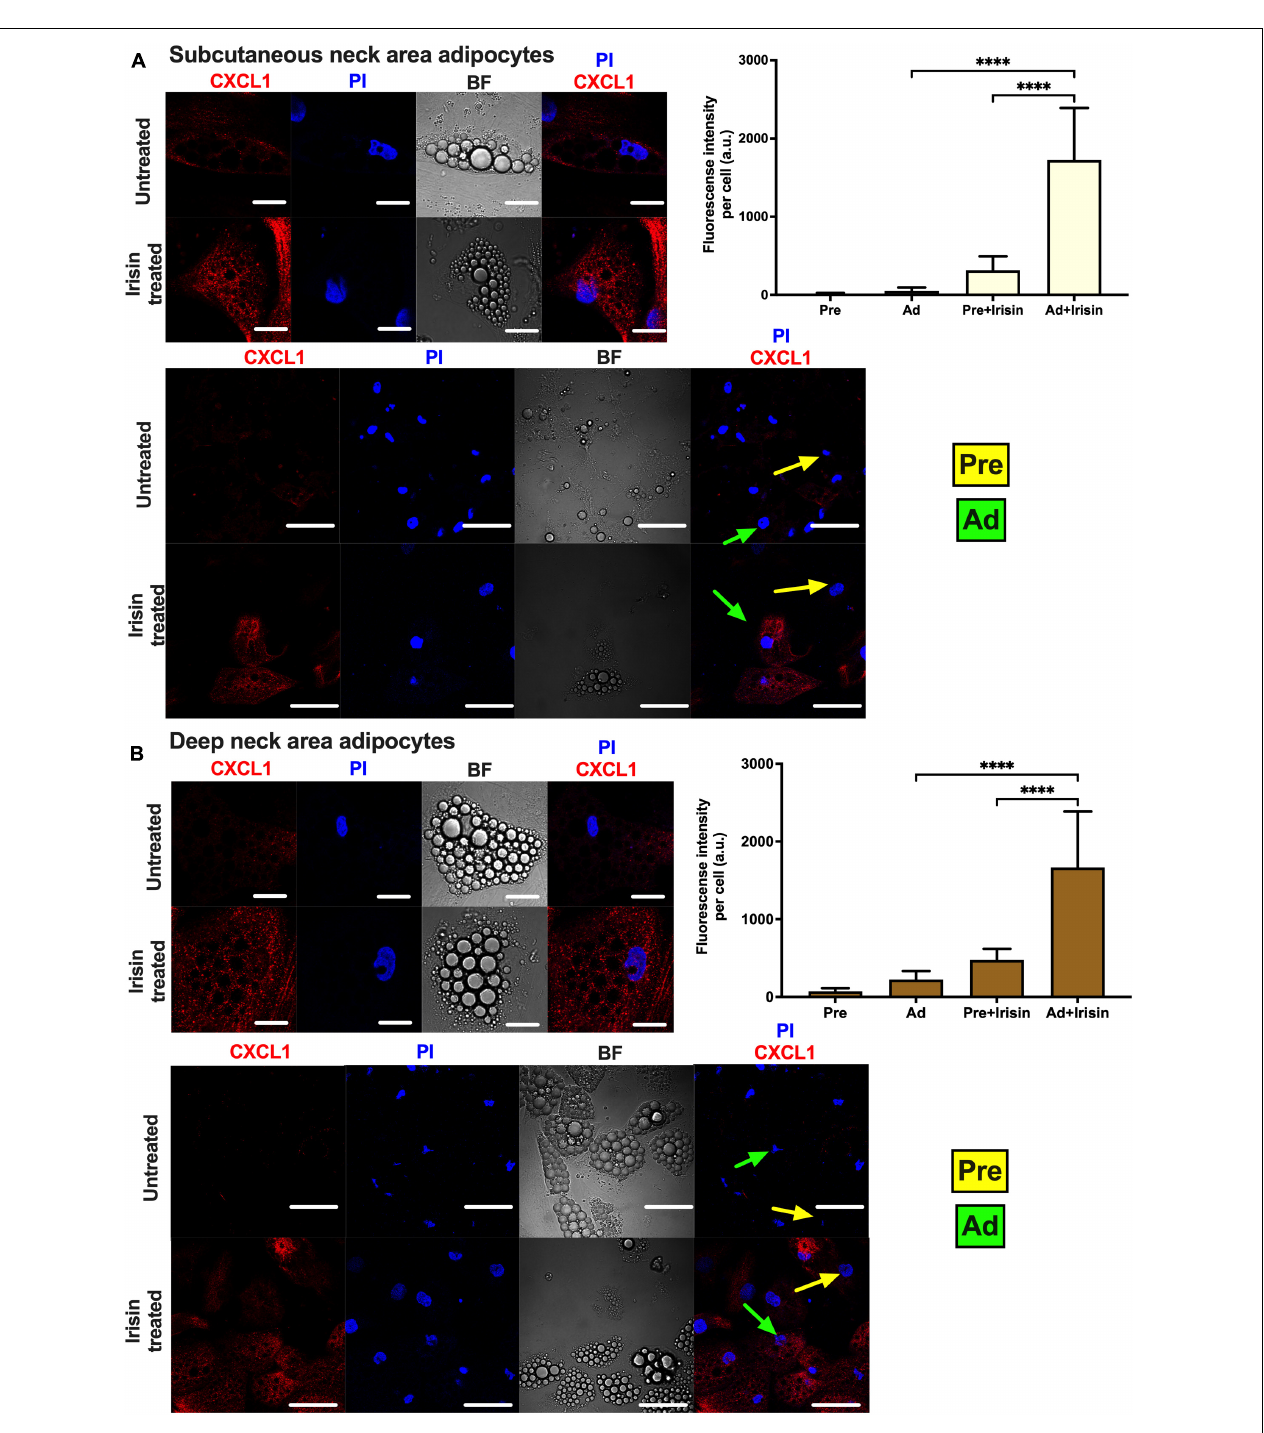
FIGURE 4 | Irisin stimulated CXCL1 release predominantly from subcutaneous (A) and deep-neck (B) area differentiated adipocytes. Preadipocytes (Pre) were plated and differentiated into adipocytes (Ad) on Ibidi chambers, with or without irisin treatment as in Figures 1–3 . Cells were treated with 100 ng/ml brefeldin-A for 24 h to block the secretion of CXCL1, which was followed by fixation and image acquisition by confocal microscopy. Propidium Iodide (PI) was used to stain the nucleus. BF represents the bright field image. Confocal images of differentiated adipocytes were shown followed by wider coverage of undifferentiated and differentiated adipocytes. Scale bars represent 10 µ m for single differentiated Ad and 30 µ m for wider coverage of Pre and Ad. Yellow and green arrows point the undifferentiated preadipocytes and the differentiated adipocytes, respectively. Quantification of fluorescence intensity normalized to per cell are shown on the right bar graphs. Data presented as Mean ± SD. n = 35 cells (A) and 50 cells (B) from two independent donors. ∗∗∗∗ p < 0.0001. Statistics: One-way ANOVA with Tukey’s post-test.